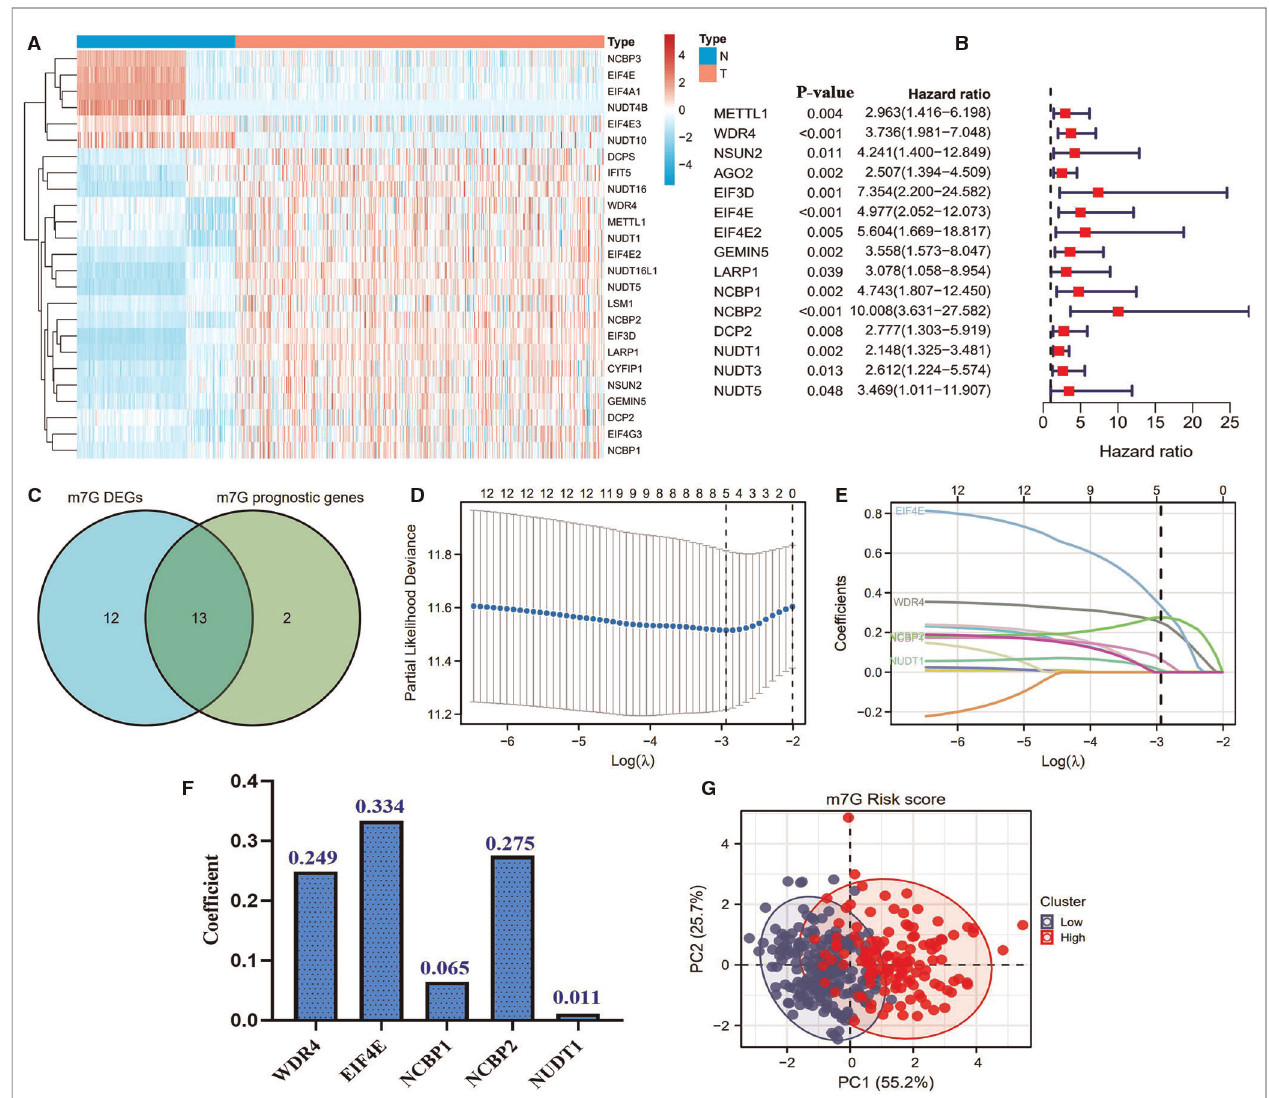
FIGURE 2 | Construction of a novel m7G risk signature. ( A ) Heatmap of m7G DEGs. Blue represents downregulated expression, and red represents upregulated expression. The bar on the left side represents the expressive Z-score. ( B ) Identi fi cation of prognostic m7G genes through cox univariate analyses. ( C ) Venn plots showing the intersection of genes between DEGs and prognostic m7G genes. ( D,E ) Process of the Lasso regression analysis. ( F ) Coef fi cients of each member gene in the m7G risk signature. ( G ) PCA plots of the m7G risk score. Survival status is used as the outcome measure. The m7G risk level is used as the clustering